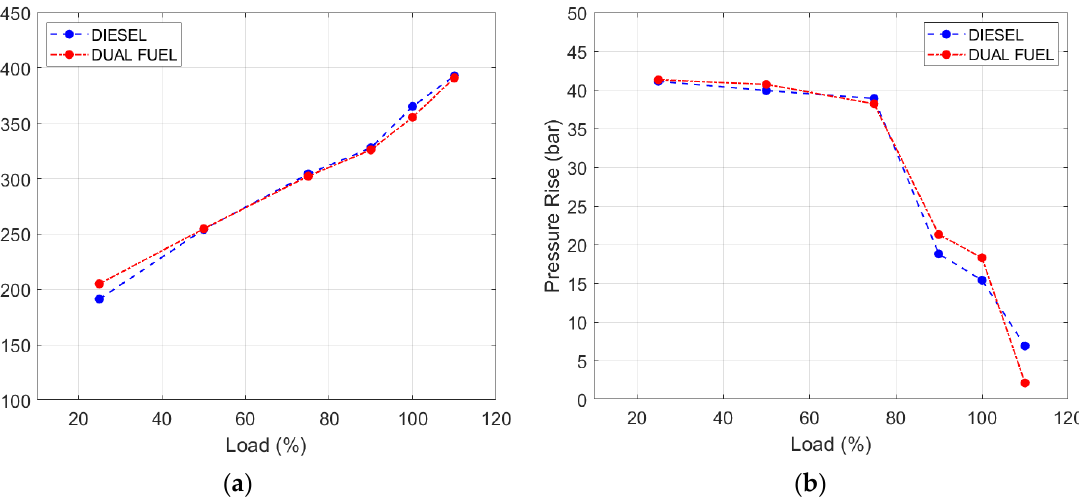
Figure 4. ( a ) Mean cylinder exhaust gas temperature, diesel and DF modes; ( b ) Pressure rise due to combustion, diesel and DF modes.